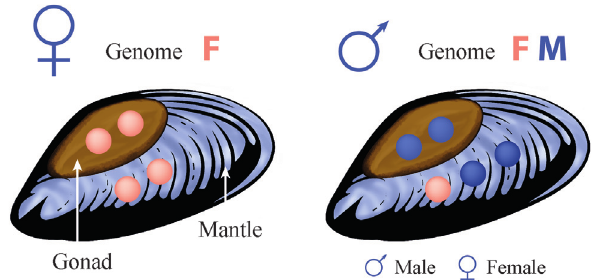
Figure 1 - Distribution of mitochondrial genomes by tissue-type and sex in the Chilean mussel Perumytilus purpuratus evaluated with sequences of the 16S region. F: F-genome; M: M-genome.